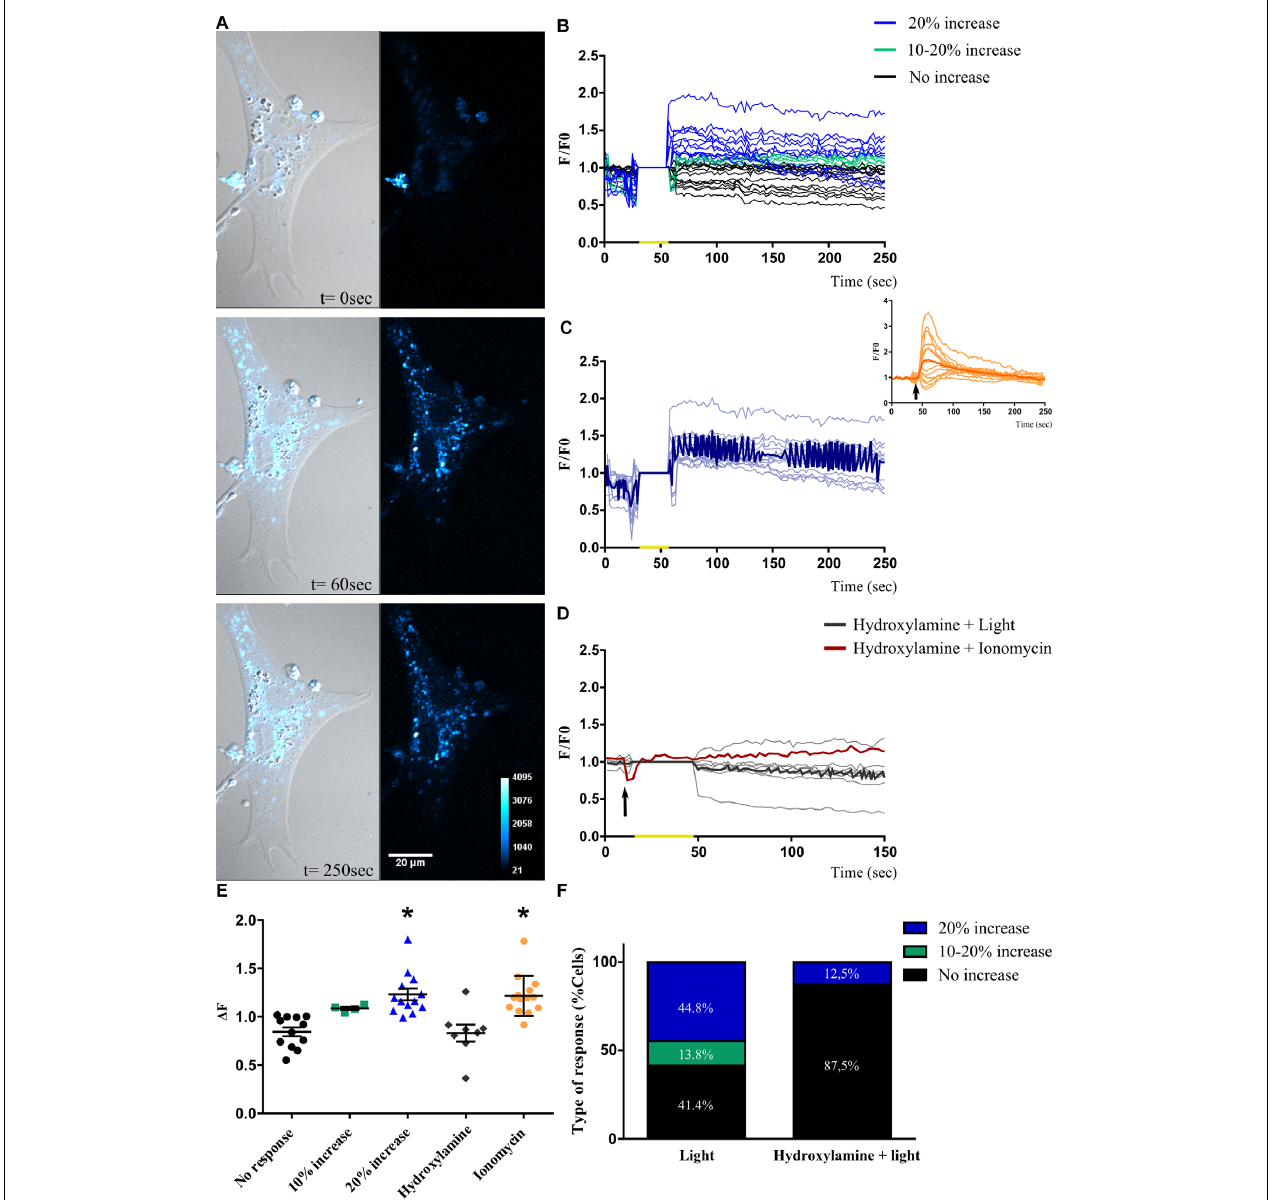
FIGURE 5 | Blue light-induced changes in intracellular Ca 2 + levels in Müller glial cells. (A) Representative Müller glial cells kept in culture for 2 weeks loaded with Calcium Orange AM and displaying a significant increase in intracellular Ca 2 + fluorescence levels after a blue light pulse (BL) of 20 s and visualized at 60 and 250 s (left panels). The Ca 2 + response is shown in a pseudo color scale with the highest response in white (right panels). Scale bar = 20 µ m. (B) Graphical representation showing the F / F o ratio for different Ca 2 + responses in Müller glial cells when exposed to a single brief BL pulse of 68 µ W/cm 2 for 20 s (yellow mark). Responses are divided into: (i) cells that did not respond to BL (black lines); (ii) cells that responded with fluorescence increase between 10–20% to BL (green lines); (iii) cells that responded with an increase in fluorescence > 20% to BL (blue lines). (C) Graphical representation of the F / F o ratio for changes in fluorescence levels in cells that responded with 20% increase in fluorescence to the BL stimulus (yellow mark). The dark blue line represents the average response of photosensitive cells. Inset shows Müller glial cells responses to ionomycin stimulation (2 µ M) (arrow). (D) Graphical representation indicating the F / F o ratio for the changes in fluorescence levels in cells pre-treated with the retinal bleacher hydroxylamine (30 mM) and stimulated with BL pulse (yellow mark; gray lines) and the ionophore ionomycin (2 µ M) (arrow; red line). (E) Graphical representation of relative fluorescent Ca 2 + levels ( (cid:49) F ) in Müller glial cells when exposed to a single brief BL pulse: black, cells that did not respond to BL; green, cells that responded with a fluorescence increase between 10 and 20% to BL; blue, cells that responded with an increase in fluorescence > 20% to BL; gray, cells pre-treated with the retinal bleacher hydroxylamine (30 mM); and orange, cells stimulated with ionomycin (2 µ M). The graph shows individual values with the media ± SEM. A one-way ANOVA revealed a significant effect of treatment of light or ionomycin [ F ( 4 , 46 ) = 10.63, ∗ p < 0.0001) compared with the no-increase in Ca 2 + levels group (51 cells from eight independent experiments). (F) Graphical representation for the percentage of each type of response in Müller glial cells pre-treated or not with hydroxylamine. The Ca 2 + increase triggered by the brief BL pulse is abolished with the retinal bleacher, suggesting an opsin-mediated response.